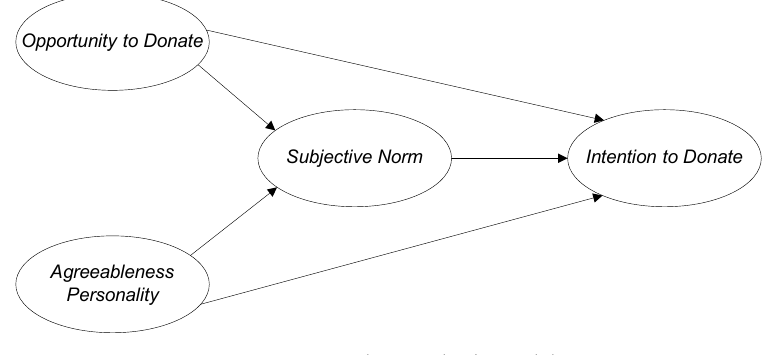
Fig. 1. Research Hypothesis Model